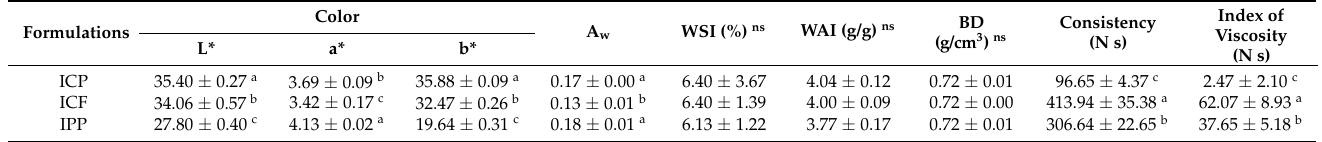
Table 4. Physical properties of instant porridge